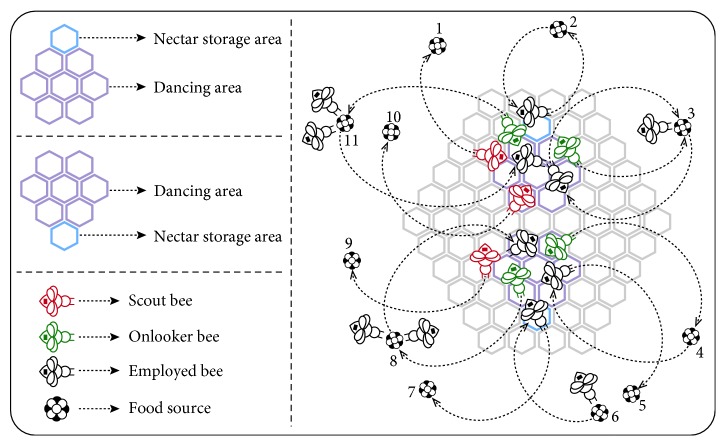
Different behaviours of the employed bees.